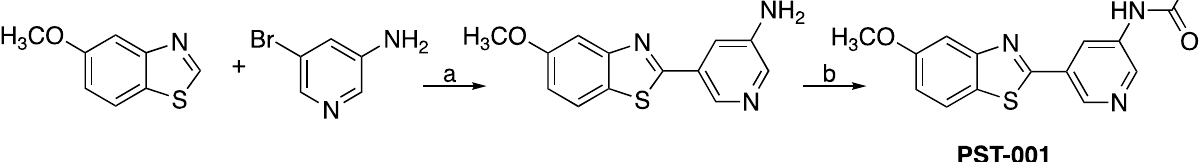
Figure 2. Preparation of PST-001. Reagents and conditions. a: Cs 2 CO 3 , Cu(I)Br, Pd(OAc) 2 , P( t -Bu) 3 , DMF, 150 °C, b: Ac 2 O, pyridine, CH 2 Cl 2 , rt.